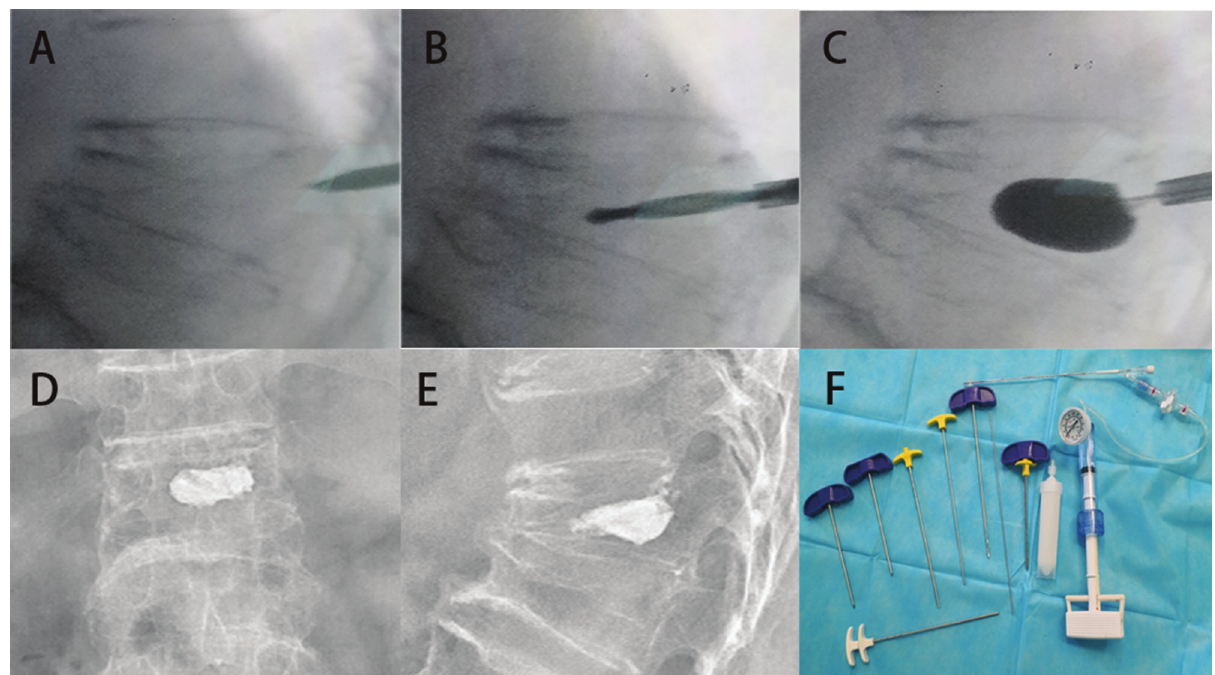
Figure 5 - BTS surgical procedure for the treatment of a 75-year-old male patient with T12 vertebral body fracture. A, A puncture needle enters into the wedge T12 vertebra via the left pedicle. B, A bone drill was inserted in the fractured vertebral body to drill a circular hole as a working channel. C, An expandable cannula was inserted into the fractured vertebral body, and the balloon was slowly inflated. D and E, Posterior-anterior and lateral X-ray films after the BTS surgical procedure. F, The BTS